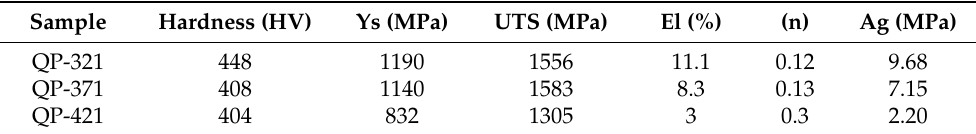
Table 4. Results of mechanical properties of studied steel.